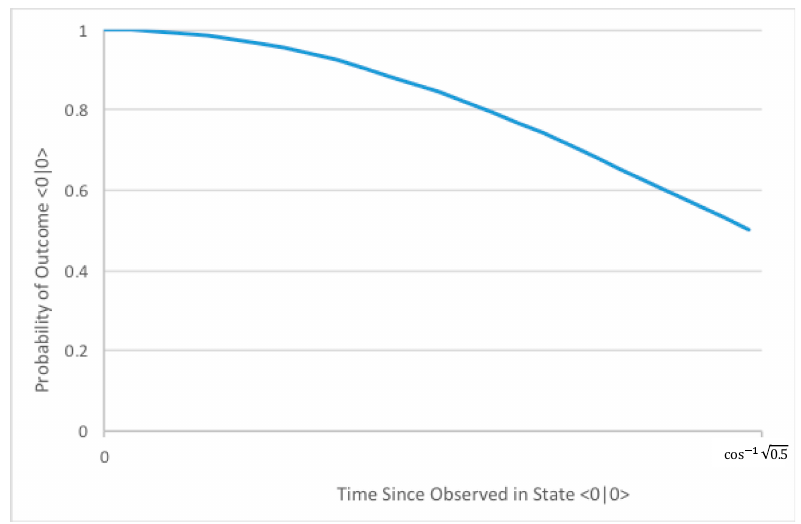
Figure 2. Probability of outcome <0|0> as a function of time since last observation of <0|0>.